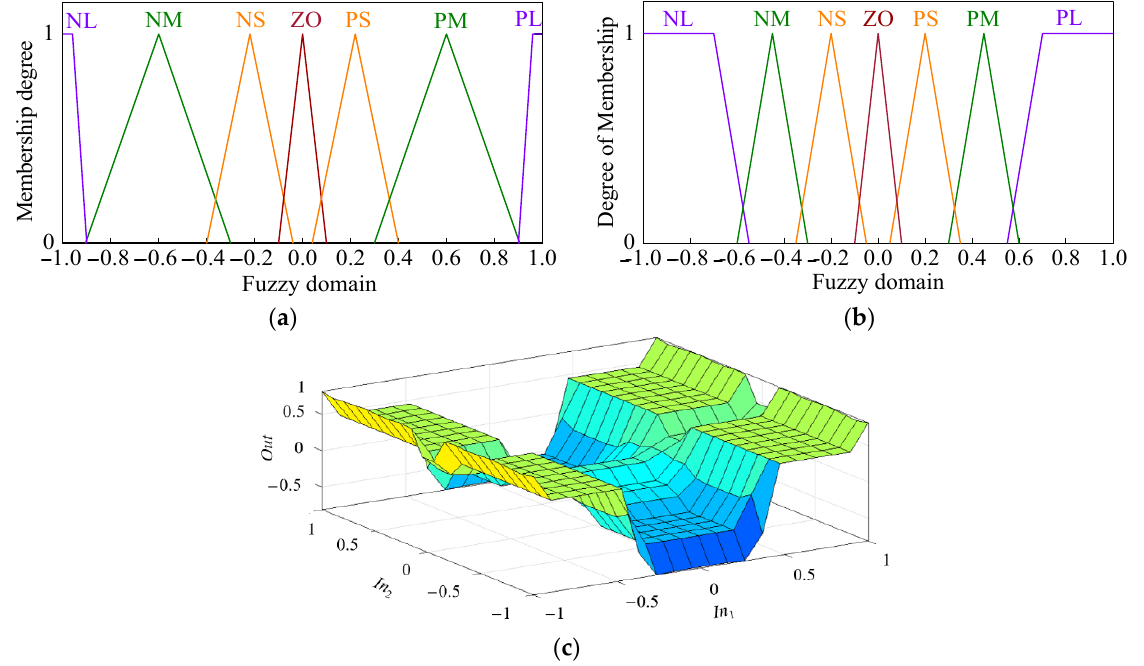
Figure 6. Fuzzy membership functions. ( a ) Membership functions for inputs; ( b ) membership functions for output; ( c ) relationship between inputs and output in the form of surface view.